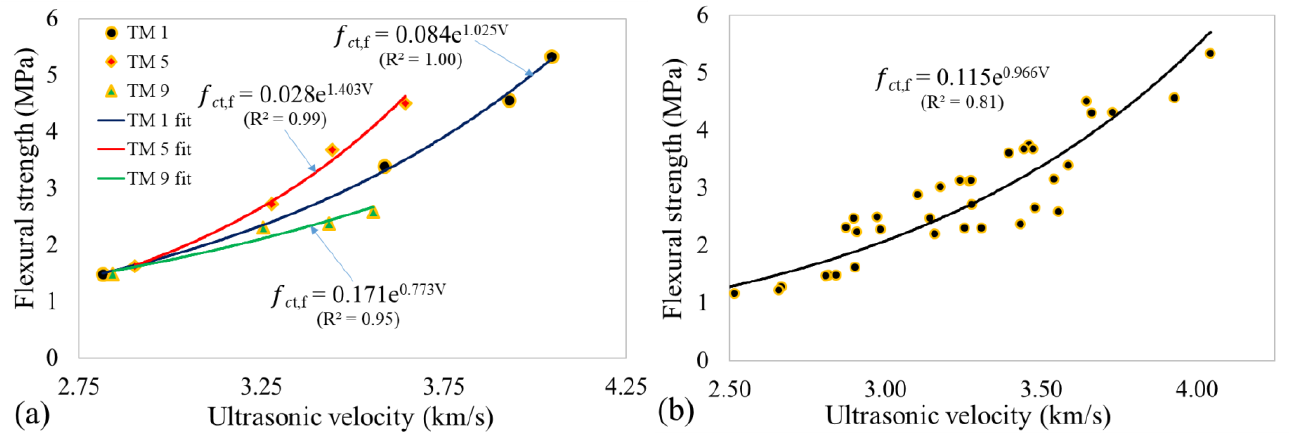
Figure 11. Ultrasonic velocity and flexural strength ( a ) TM 1, TM 5, and TM 9, ( b ) all specimens. The ultrasonic velocity and its relationship with strength are influenced by the type of source material, aggregate size, type and proportion, the mixture’s air content, curing temperature, and presence of admixtures [19,52,57,62,63]. This study investigated only one type of AAC, and hence the results are limited to the studied AAC parameters. There- fore, it is necessary to accumulate more experimental data considering the various influ- ence factors to improve its reliability.